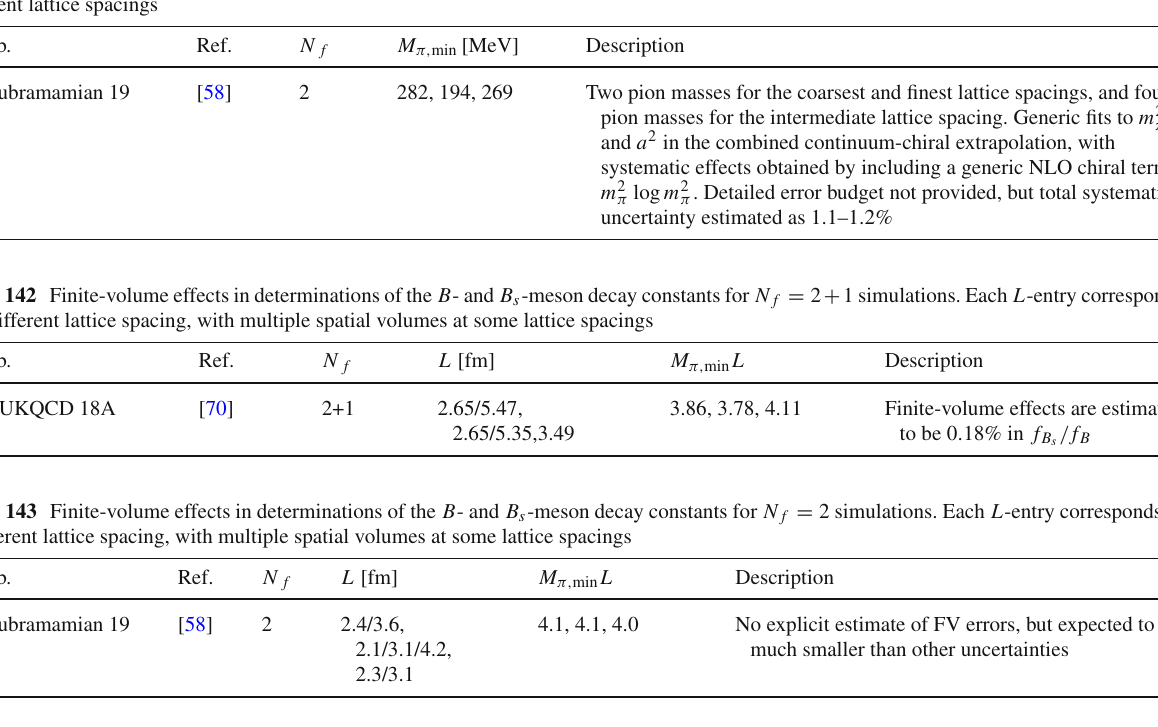
Table 144 Continuum extrapolations/estimation of lattice artifacts in determinations of the B and B s meson decay constants for N f = 2 + 1 simulations